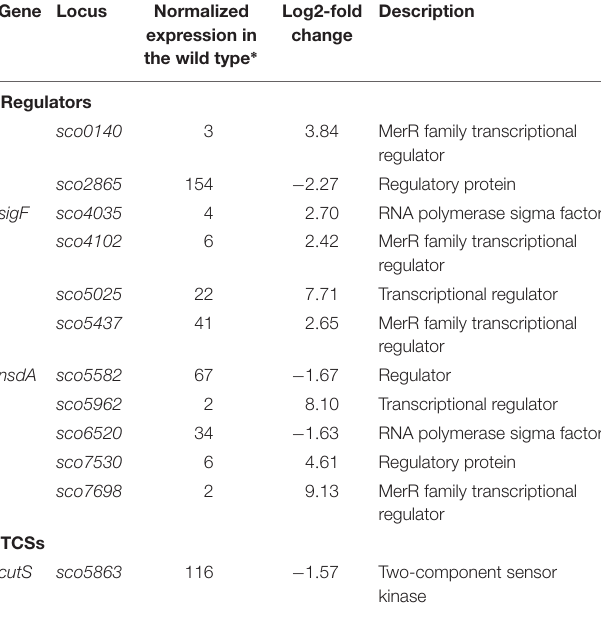
TABLE 7 | Regulatory protein-encoding genes impacted by constitutive topA -upregulation (based on RNA-Seq data; log2-fold > 1.5; p < 0.05). Gene Locus Normalized expression